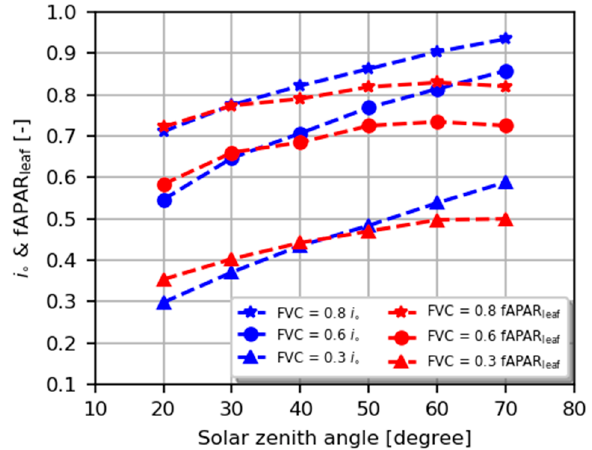
Figure 3. DART canopy interceptance ( i o , in blue color) and fraction of absorbed photosynthetically active radiation only by leaves (fAPAR leaf , in red color). Three simulation results for each of them are shown here: FVC = 0.3, 0.6, and 0.8.